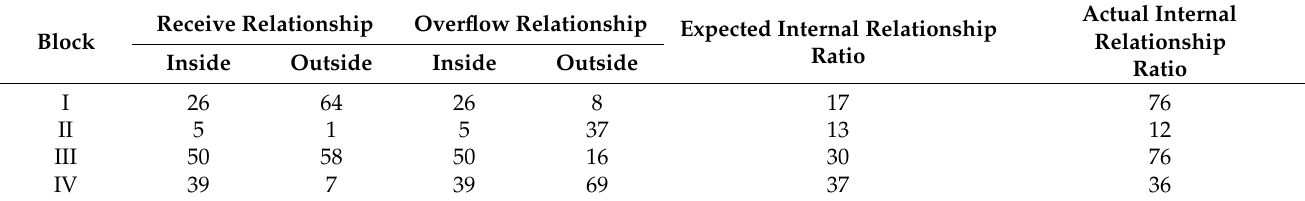
Table 2. Analysis of spillover